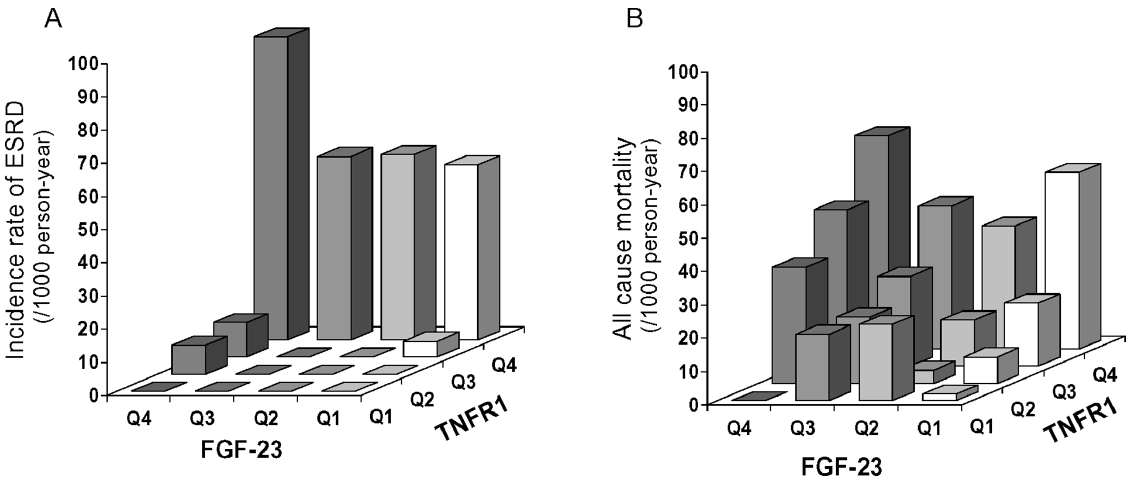
Figure 1. Incidence rate of ESRD and all-cause mortality stratified by quartiles of FGF-23 and TNFR1. Figure 1A demonstrates incidence rate of ESRD and Figure 1B shows incidence of all cause mortality. Q1–Q4 represents quartiles 1 to 4. Quartile cut-off values were 1049, 1302, and 1812 pg/mL for TNFR1 and 42, 60, and 96 RU/mL for FGF-23, respectively. Increasing color intensity of the columns corresponds to higher concentrations (quartiles) of